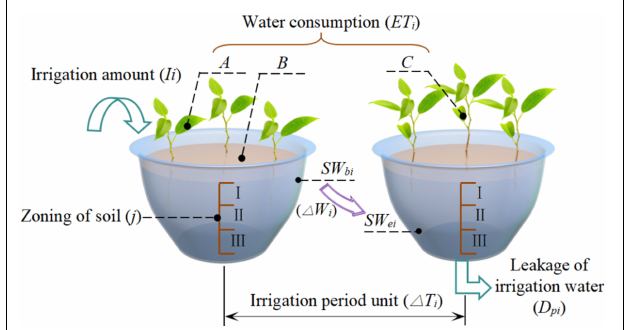
FIGURE 3 | Schematic of test principle. The image shows the principle of water balance for the greenhouse potted crops within the research period (i.e., irrigation unit (cid:49) T i ). (A–C) represent crop transpiration, soil evaporation between crops, and volume of water contained within a plant, respectively. The crop water consumption ( ETi ) during the research period is the sum of A, B, and C. Symbols SW bi and SW ei represent the soil water content at the beginning and end of the research period, respectively. Thus, the change in soil water content during the research period is (cid:49) W i = SW ei — SW bi . Labels I, II, and III represent the zoning ( j ) of the soil in the experimental